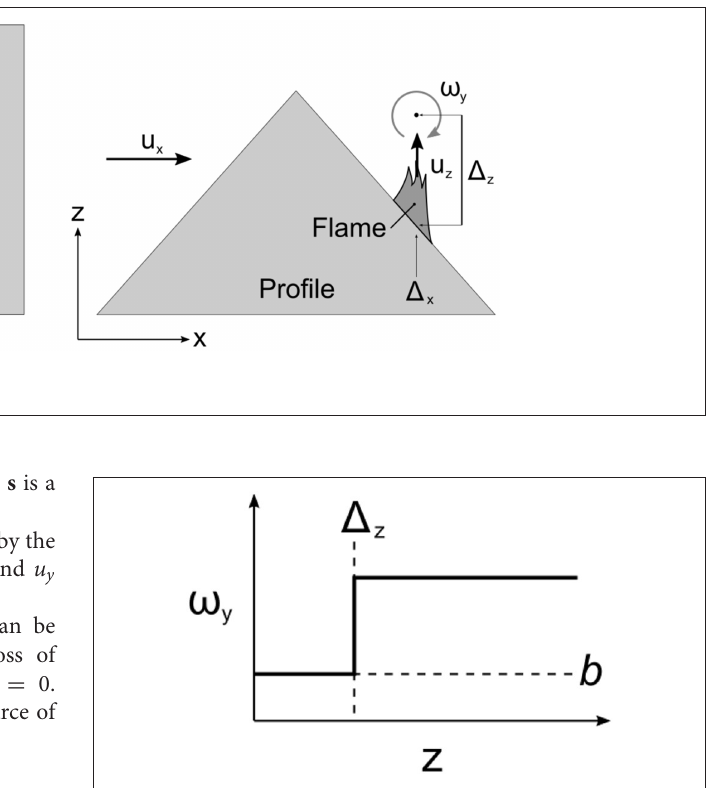
FIGURE 4 | Vorticity ω y as a function of height z